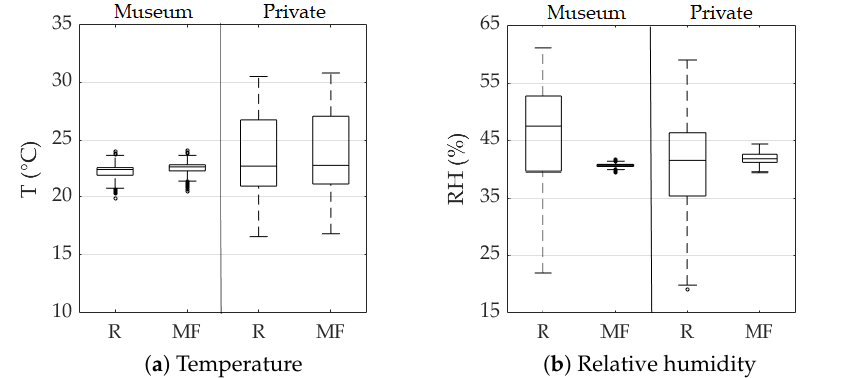
Figure 2. Box-and-whisker plot of temperature ( a ) and relative humidity ( b ) inside the microclimate frame (MF) and in the surrounding room (R) throughout a solar year. Outliers are indicated as points.